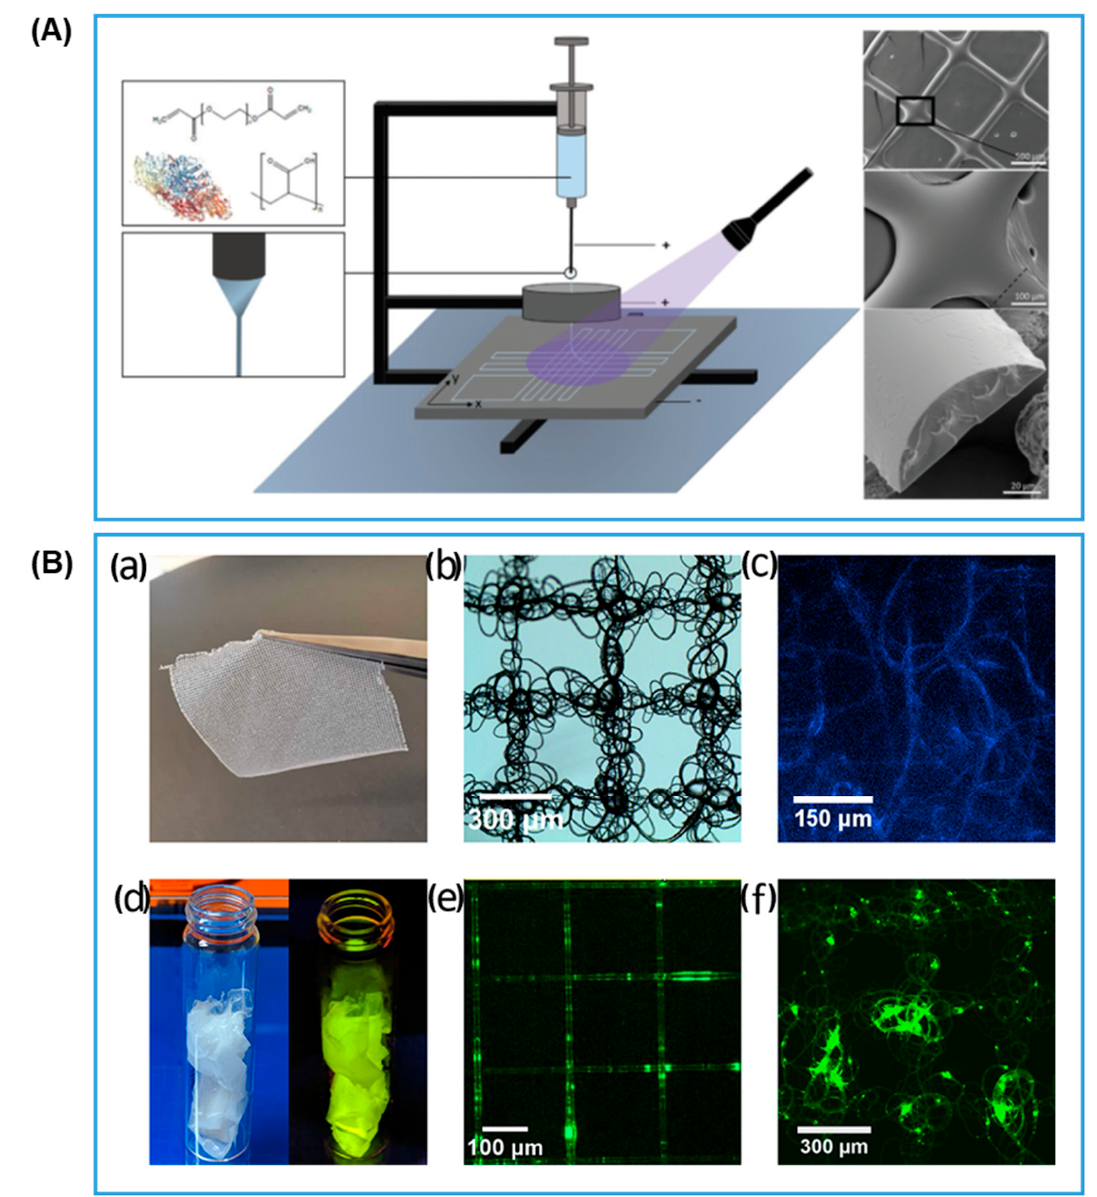
Figure 12. ( A ) The 3D jet writing of hydrogel fibers yielding oriented hydrogel fibers loaded with enzymes (reproduced with permission from Ref. [80]). ( B ) Melt electrowriting of PCL with entrapped electrostatically stabilized enzymes/proteins: ( a ) photo of the fabric with area of 3 cm 2 ; ( b ) widefield microscopy view of the fine structures of the printed fabric with fiber thickness <5 µ m; ( c ) enzymatic activity after the melt electrowriting process as shown by the fluorescent emission from the enzyme catalyzed hydrolysis reaction; ( d ) fluorescent plastics created by entrapping superfolder green fluorescent protein into PCL; ( e ) printed ordered grid structure with fluorescent PCL; and ( f ) the fluorescent plastics were used to print fabrics with repetitive tangles (reproduced with permission from Ref.